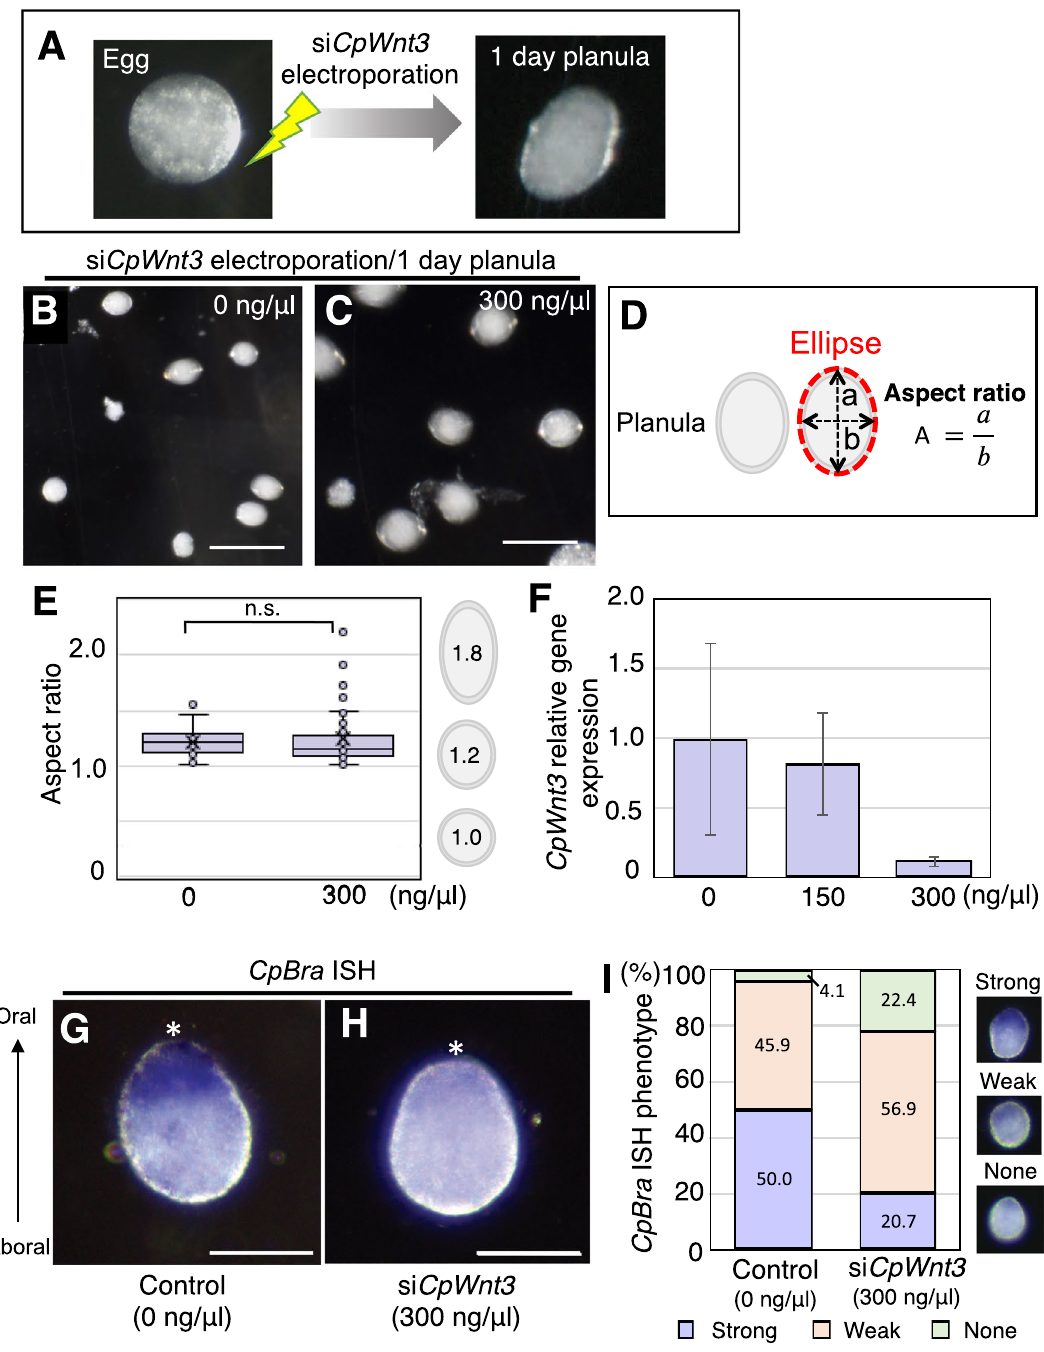
Figure 5. Phenotypes of Wnt3 knockdown with siRNA in Cladonema fertilized eggs. ( A ) Typical morphology of Cladonema egg and planula. The wild-type Cladonema planula larvae exhibit a slight oval shape. To deliver siRNAs targeting CpWnt3, electroporation was performed in fertilized eggs (1-cell stage), and phenotypes were confirmed at planula in one day. ( B , C ) Phenotypes of 1-day planula after CpWnt3 siRNA knockdown. ( D ) Schematic of ellipse approximation for planula morphology and calculation of the aspect ratio. The aspect ratio was calculated by dividing the long axis (a) by short axis (b). ( E ) Boxplots showing the aspect ratio of the 1-day planula after si CpWnt3 electroporation (0 and 300 ng/µl). Center lines show the medians; x’s denote the mean values; box limits indicate the 25th and 75th percentiles; whiskers show maximum and minimum values; inner points and outliers are represented by circles. Number of examined planulae: 0 ng/µl, n = 22; 300 ng/µl, n = 50. p = 0.658303. n.s., not significant. ( F ) Quantification of CpWnt3 mRNA levels in 1-day planula by RT-qPCR. CpEF1alpha was used as an internal control. Bar heights represent the mean value. Error bars indicate standard deviation. CpWnt3 expression levels are standardized relative to the control (0 ng/µl). Experiments were performed in triplicate and repeated three times. p-values: 150 ng/μl, p = 0.376498; 300 ng/μl, p = 0.073956. ( G, H ) Representative in situ hybridization (ISH) image of oral CpBra expression in 1-day planula for control (G: 0 ng/µl si CpWnt3 ) and CpWnt3 siRNA (H: 300 ng/µl si CpWnt3 ). The oral pole is indicated by an asterisk. ( I ) Quantification of CpBra expression phenotypes based on ISH images. Stacked bar plots show the percentage of 1-day planulae in each phenotypic class. CpBra expression patterns are categorized into three phenotypes (strong, weak and none). 0 ng/µl, n = 74; 300 ng/µl, n = 58. Scale bars: ( B, C ) 200 µm, ( G, H ) 50